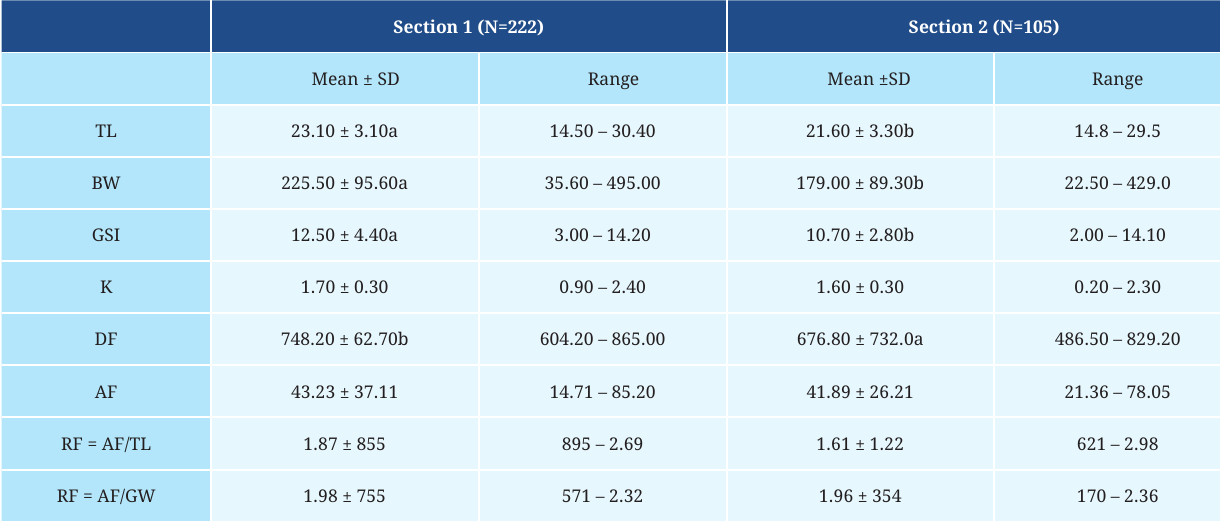
TABLE 1 | Biological parameters measured for female Leporinus piau captured in two sections of the São Francisco River Basin (SFR) from May 2015 to April 2016: section 1 - Três Marias Reservoir (TMR); section 2 - SFR downstream of TMR at the confluence of the SFR with the Abaeté River. N = number of fish caught; TL = total length; BW = body weight; GSI = gonadosomatic index at maturation/mature stage; K = Fulton